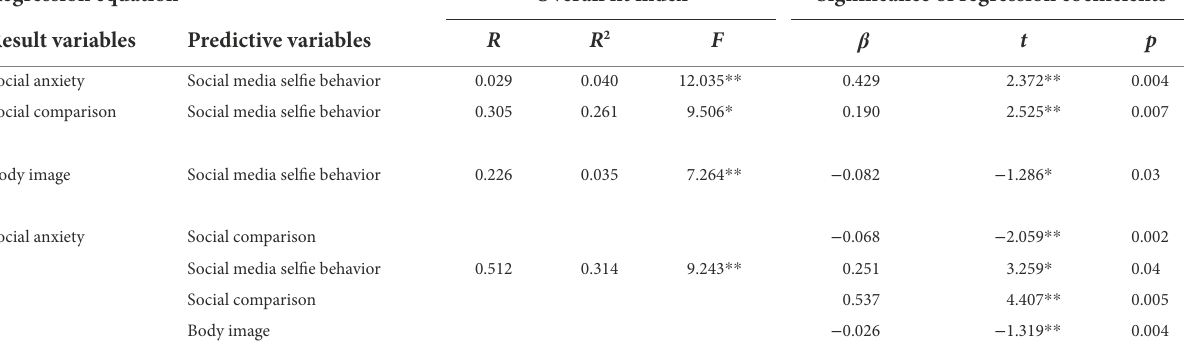
TABLE 6 Table of regression analysis of the relationship between variables. Regression